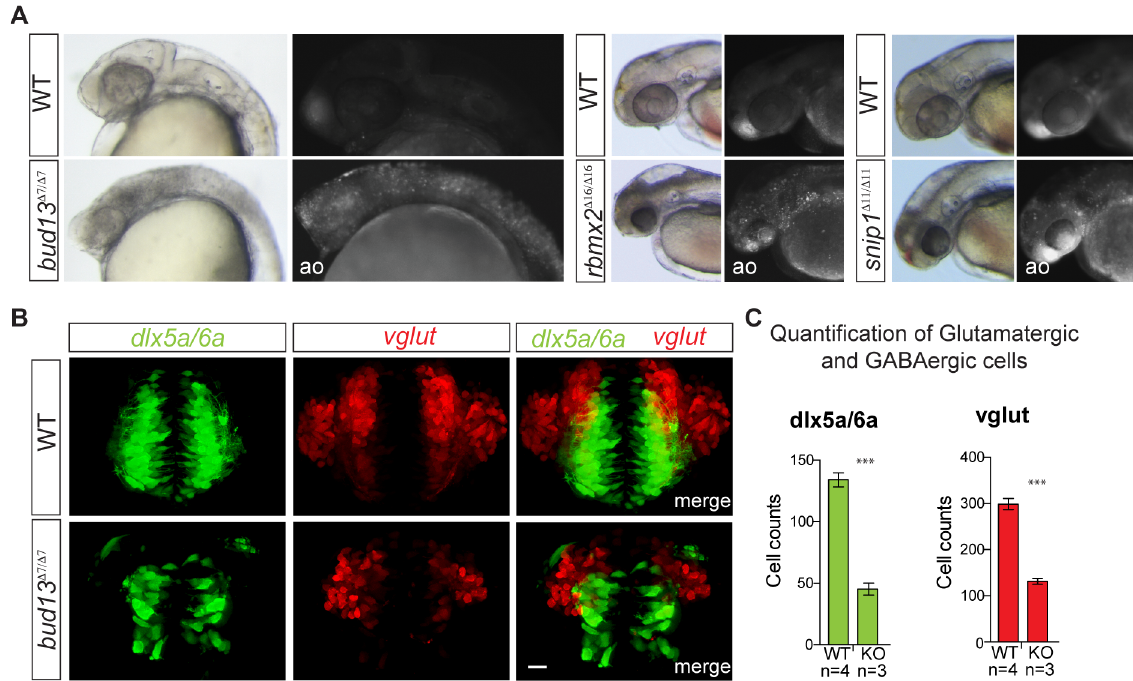
Fig 2. RES complex is required during zebrafish brain development. (A) Acridine orange (ao) staining of zebrafish mutant embryos for bud13 (30–32 hpf), rbmx2 and snip1 (48 hpf). Mutants show a marked degree of cells with nuclear uptake of ao compared to WT sibling most predominantly in the head. WT: represent phenotypically wild type sibling from the same mutant fish line. (B) Maximum intensity projections of individual and merged channels (GFP and dsRed) of 3D confocal images of bud13 Δ 7/ Δ 7 and their wild-type siblings (scale bar 20 μ m) in transgenic lines that label GABAergic neurons and precursors (Tg[dlx6a-1.4kbdlx5a/ dlx6a:GFP]) and glutamatergic neurons (Tg [vglut:DsRed]). WT: represent phenotypically wild type sibling from the same mutant fish line. (C) Total number of dlx5a/6a:GFP+ cells (GABAergic neurons and precursors) and vglut:DsRed+ cells (glutamatergic neurons) in the forebrain of the bud13 Δ 7/ Δ 7 (n = 3) and WT sibling (n = 4) were quantified. (cid:3)(cid:3)(cid:3) vglut: P = 2 x 10 −4 ; (cid:3)(cid:3)(cid:3) dlx5a/6a: P = 3 x 10 −4 (one-way ANOVA).